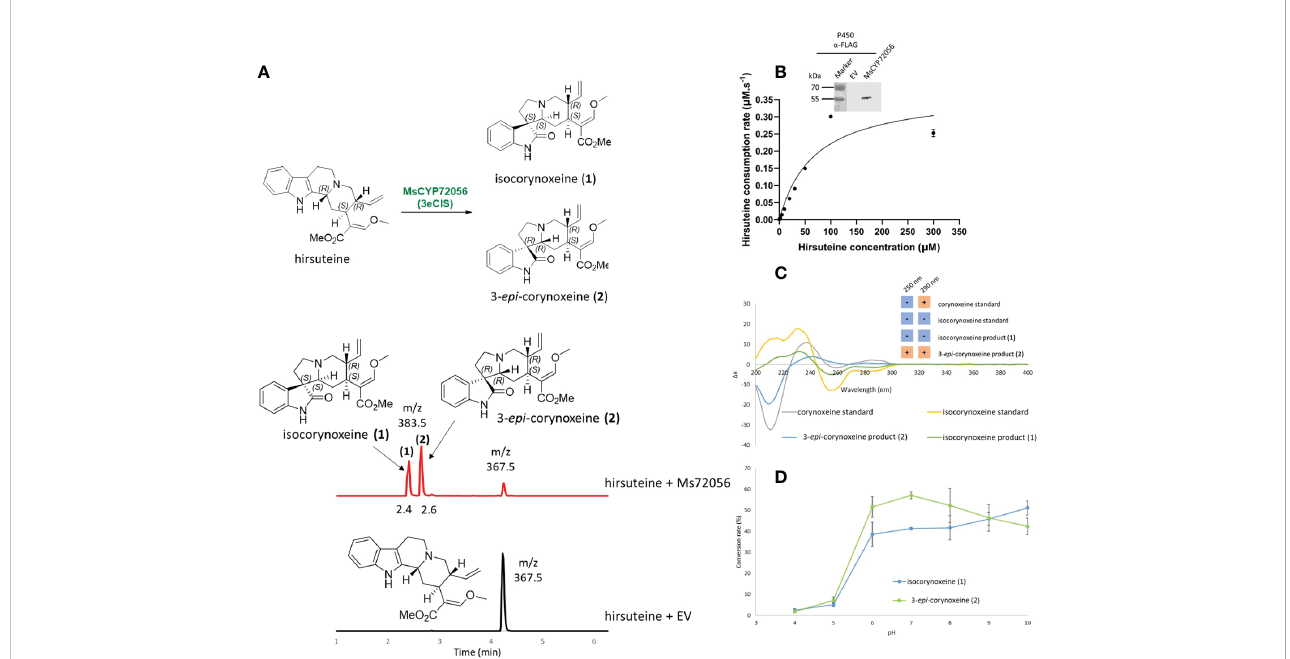
FIGURE 2 The activity of 3eCIS (MsCYP72056) with hirsuteine as substrate. (A) Enzymatic reaction and extracted ion chromatograms from LC-MS analysis showing the in vitro activity of MsCYP72056 with hirsuteine in HEPES pH 7.5 buffer. (B) Immunoblotting and enzyme kinetics of MsCYP72056 using total microsomal protein extraction of S. cerevisiae expressing MsCYP72056/CPR. (C) Circular dichroism spectra and Cotton effects at 250 nm and 290 nm of corynoxeine, isocorynoxeine, and enzymatic products 1 and 2 . (D) Product pro fi le of in vitro assays of recombinant MsCYP72056 at different